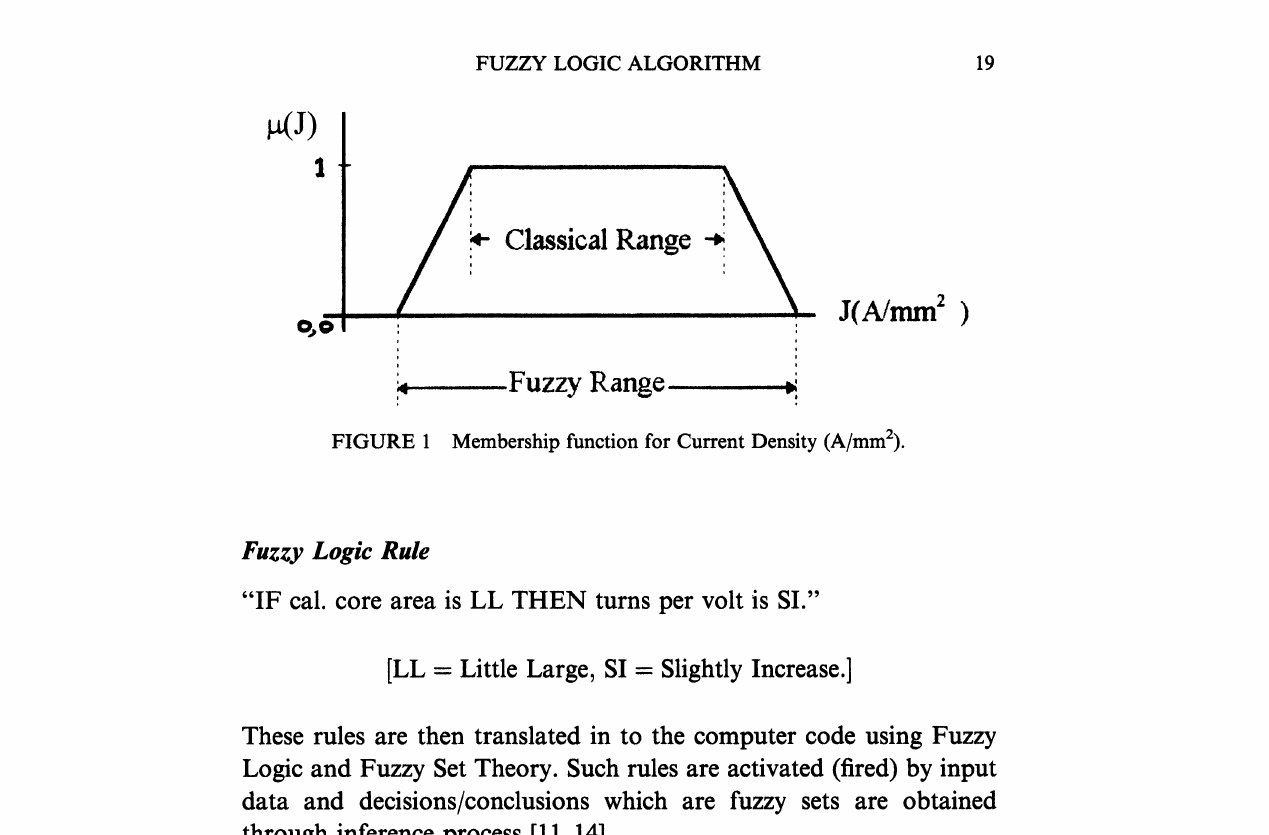
FIGURE Membership function for Current Density